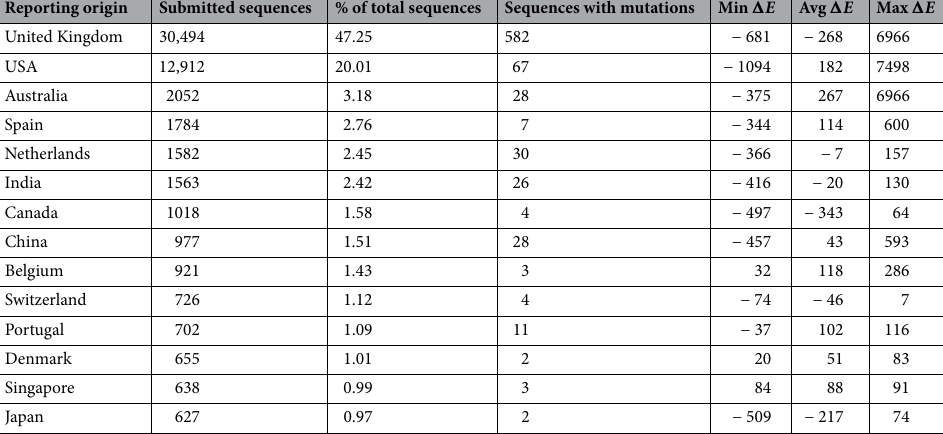
Table 1. Top reporting countries for spike sequences on GISAID.